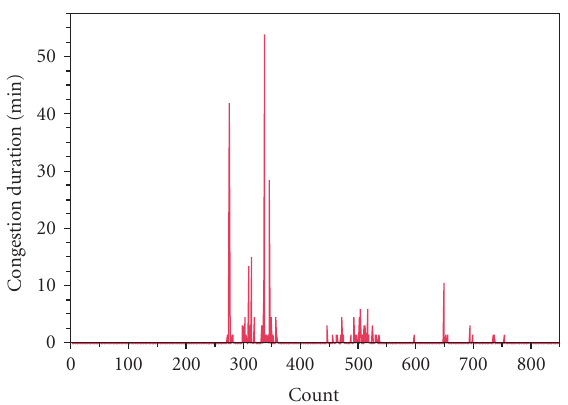
Figure 4: Congestion duration data time-series for a typical day in one of the arterial links under investigation.